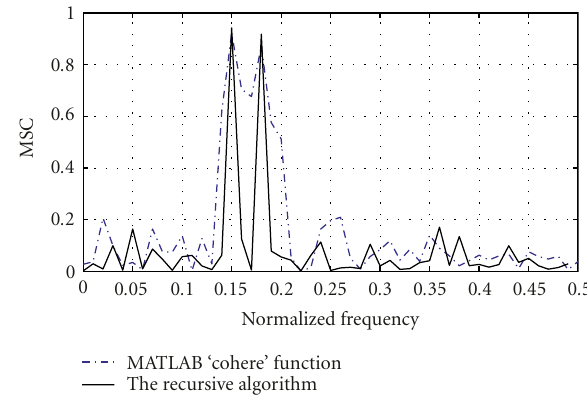
Algorithm 3: An MSC estimation based on the Capon method. where u ( n ) is a real white Gaussian noise with variance σ 2 u = 1.